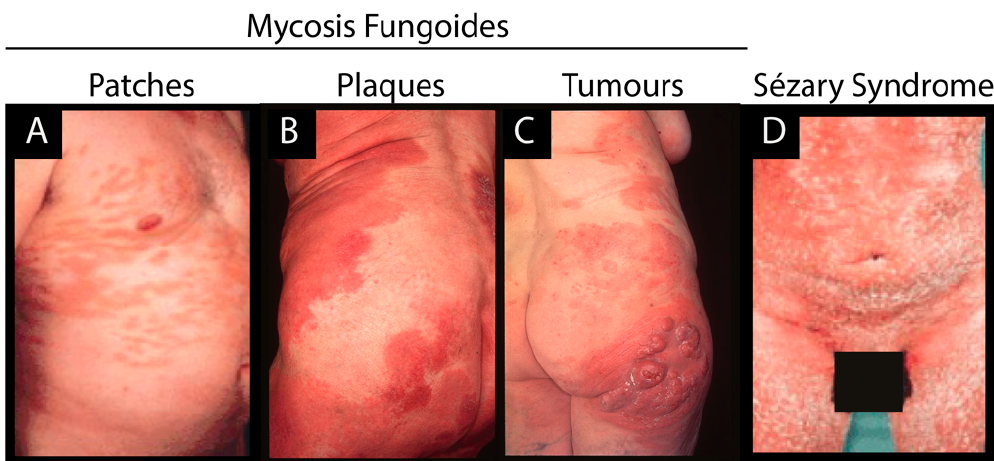
Figure 1. Stages and subtypes of cutaneous T-cell lymphoma (CTCL). ( A ), ( B ) and ( C ): The three main stages of mycosis fungoides (MF). ( D ) A patient suffering from Sézary syndrome